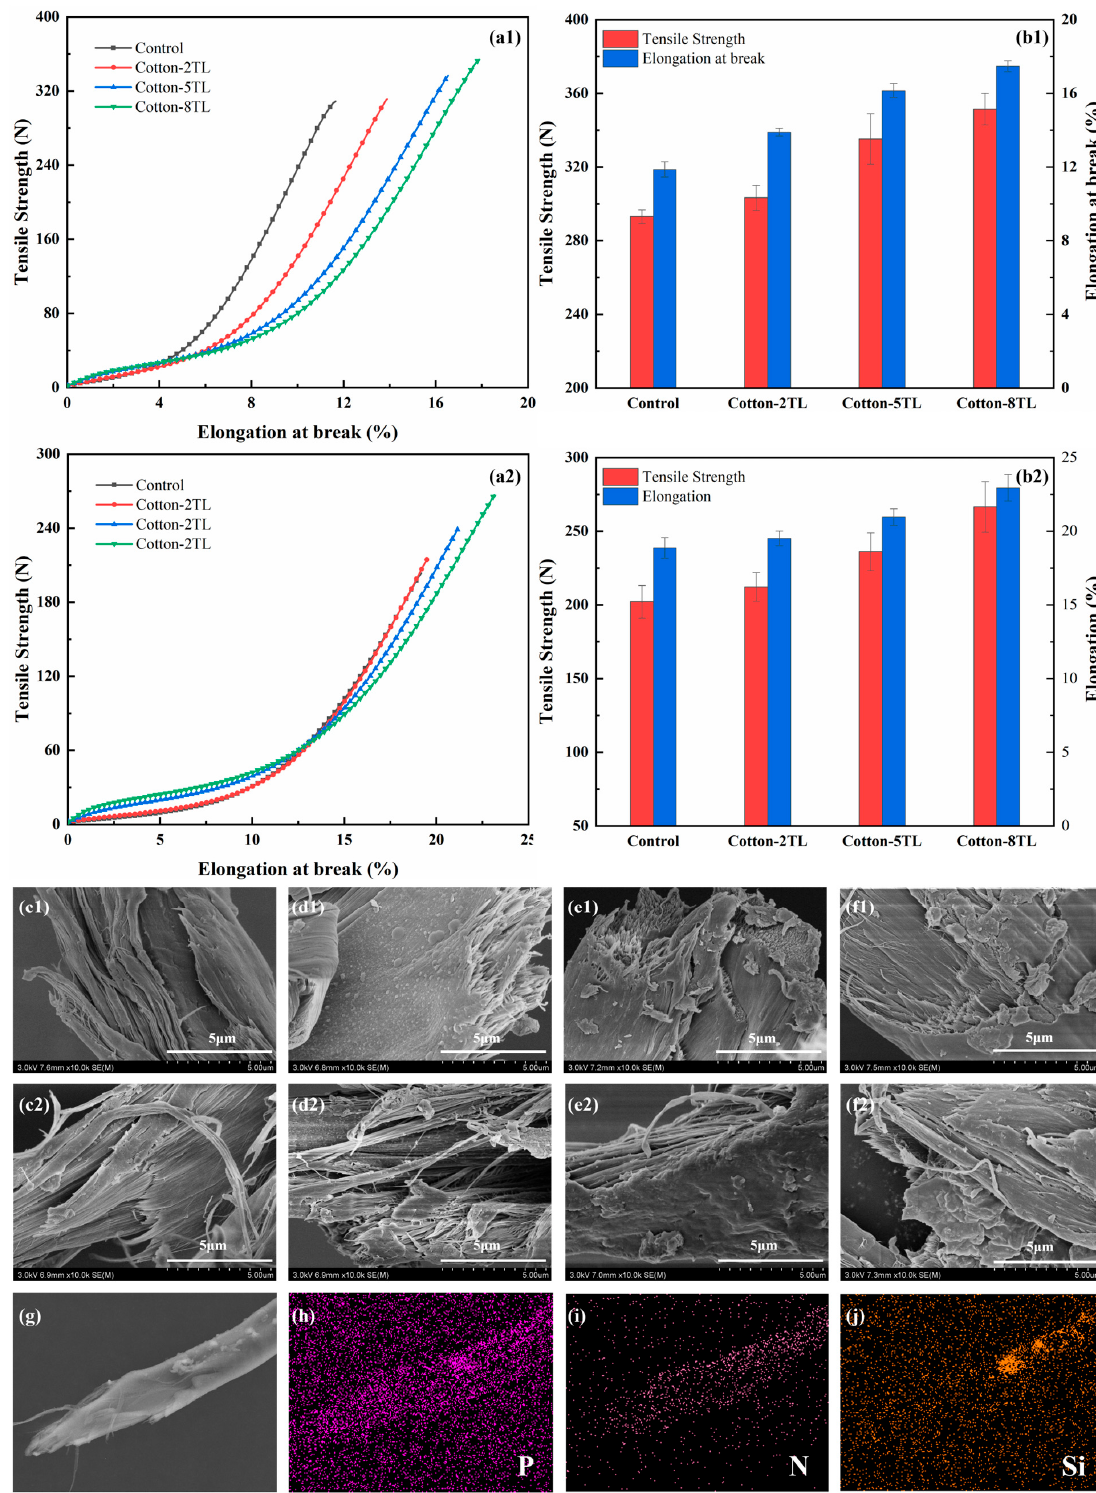
Figure 8. Stress ‐ strain curves and mechanical properties of samples in the ( a1 , b1 ) warp and ( a2 , b2 ) weft direction. SEM images of the fracture area of the ( c1 , c2 ) Control, ( d1 , d2 ) Cotton ‐ 2TL, ( e1 , e2 ) Cotton ‐ 5TL, ( f1 , f2 ) Cotton ‐ 8TL in the warp and weft direction. ( g – j ) EDS mapping of element distribution on the fracture area of Cotton ‐ 8TL in the warp direction.